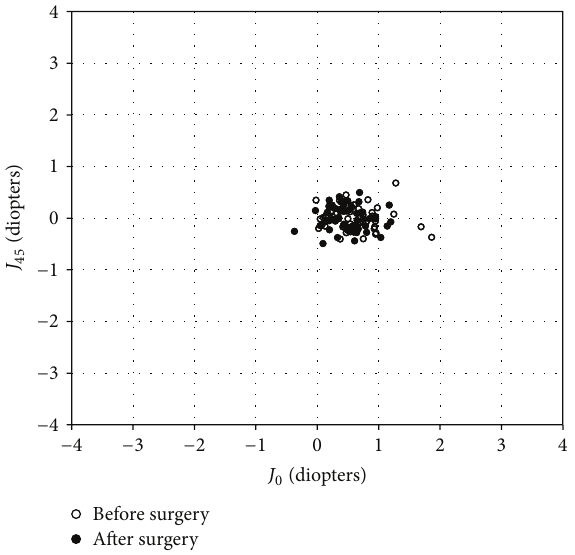
Figure 1: Power vector analysis of anterior corneal astigmatism before and after refractive lenticule extraction (ReLEx), plotted as an astigmatic vector for each eye, referenced to the spectacle